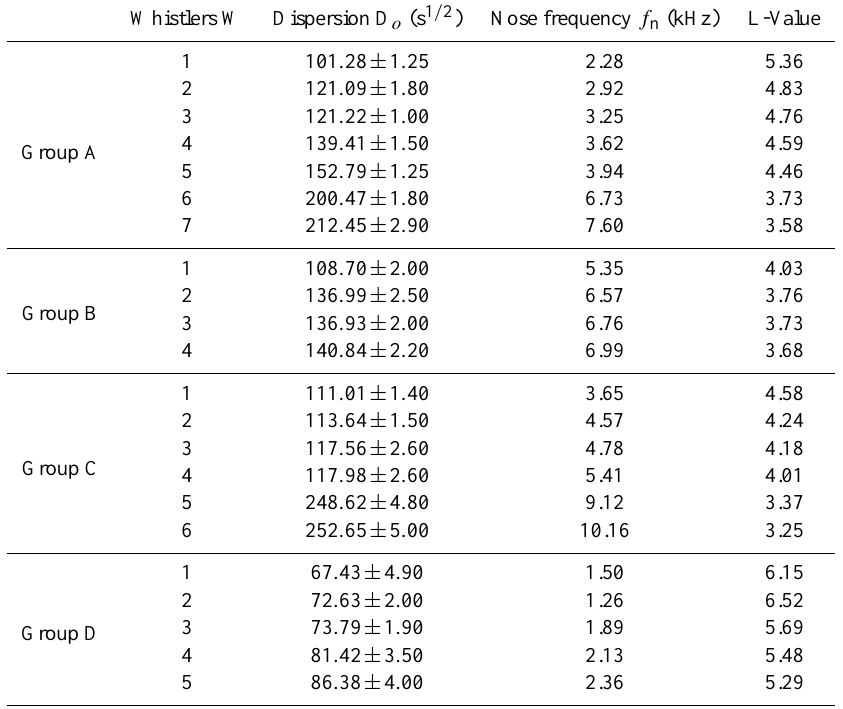
Table 1. Parameters estimated from the analysis of multiple whistlers observed at Jammu on 4 March 1998, 09:31:15h.